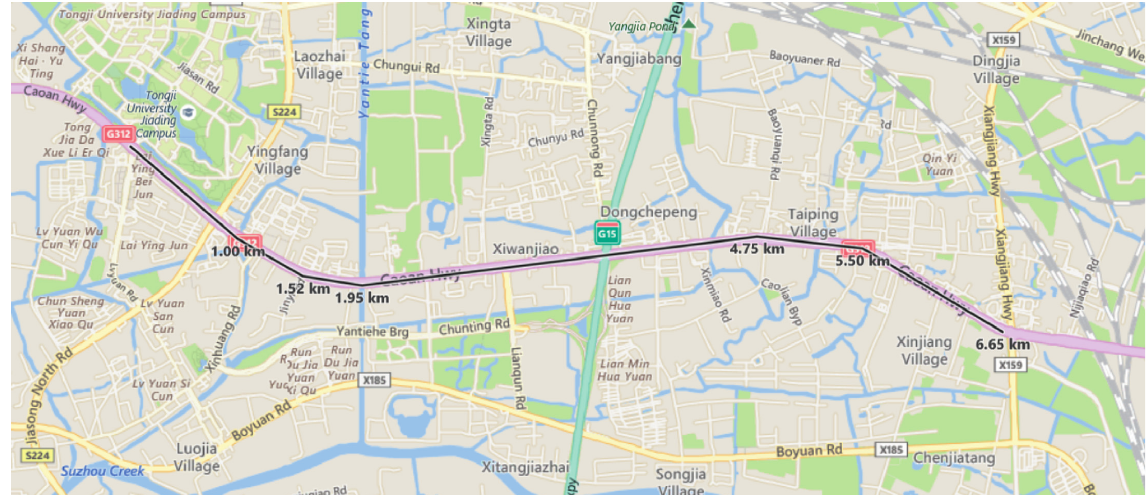
Figure 3: The experimental road section on Caoan Road in Shanghai.